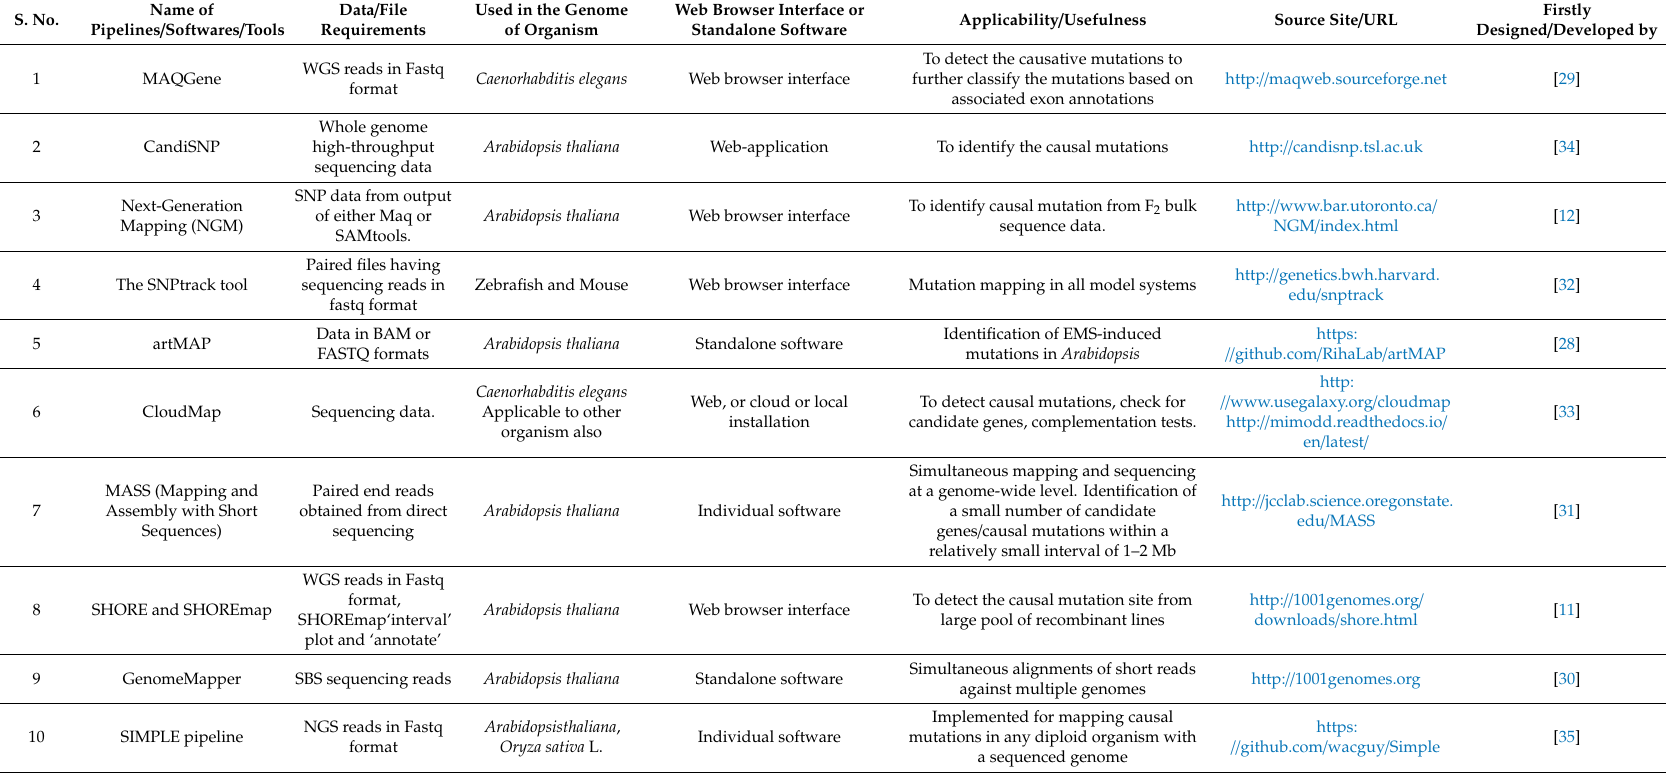
Table 4. List of commonly used bioinformatics software / pipelines for identification and mapping of causal